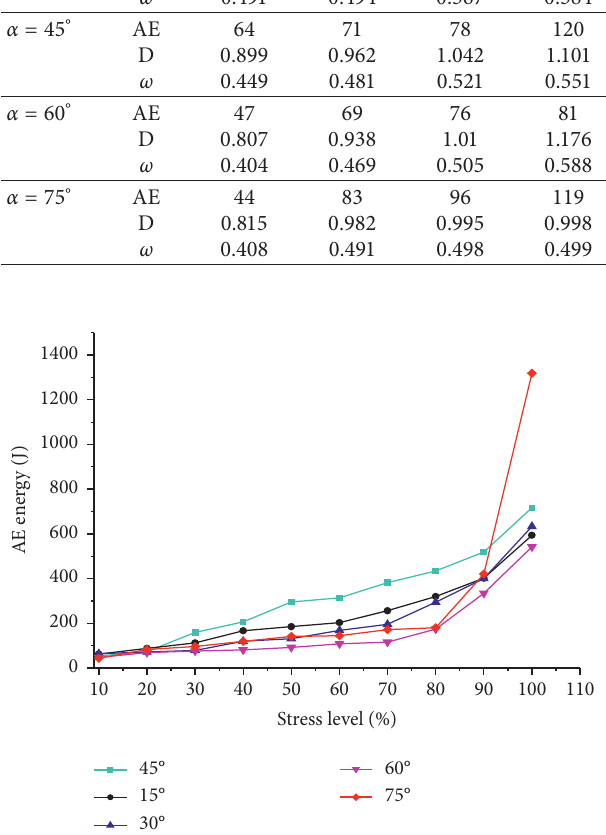
Figure 12: The connection between AE energy and various levels of